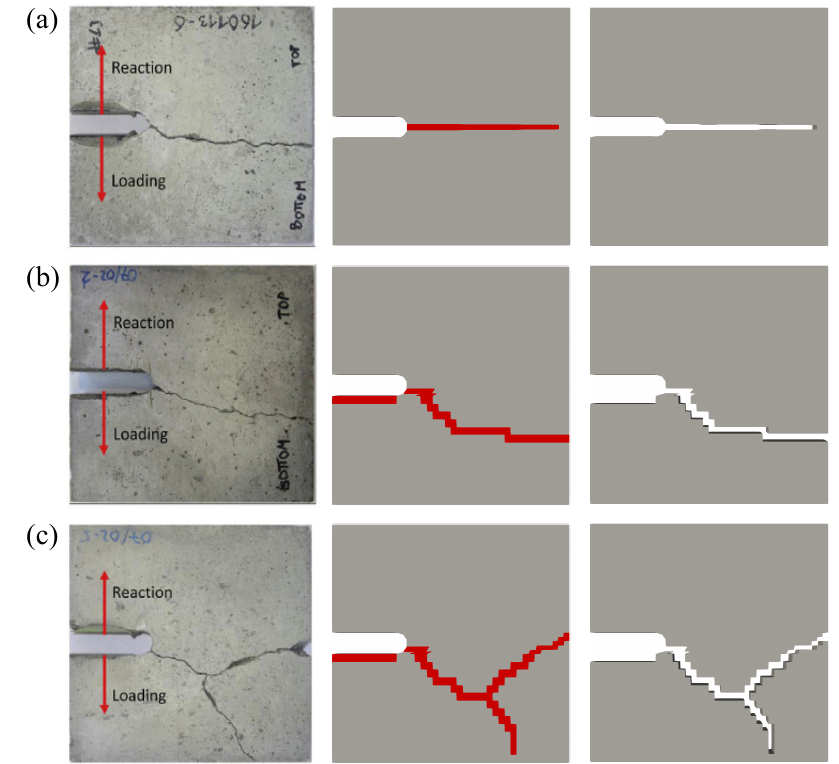
Figure 6. Simulation of compact tension specimens displaying crack paths and removed elements compared to experiments in [41] at three different velocities: ( a ) 0.035 m/s, ( b ) 1.4 m/s, and ( c ) 4.3